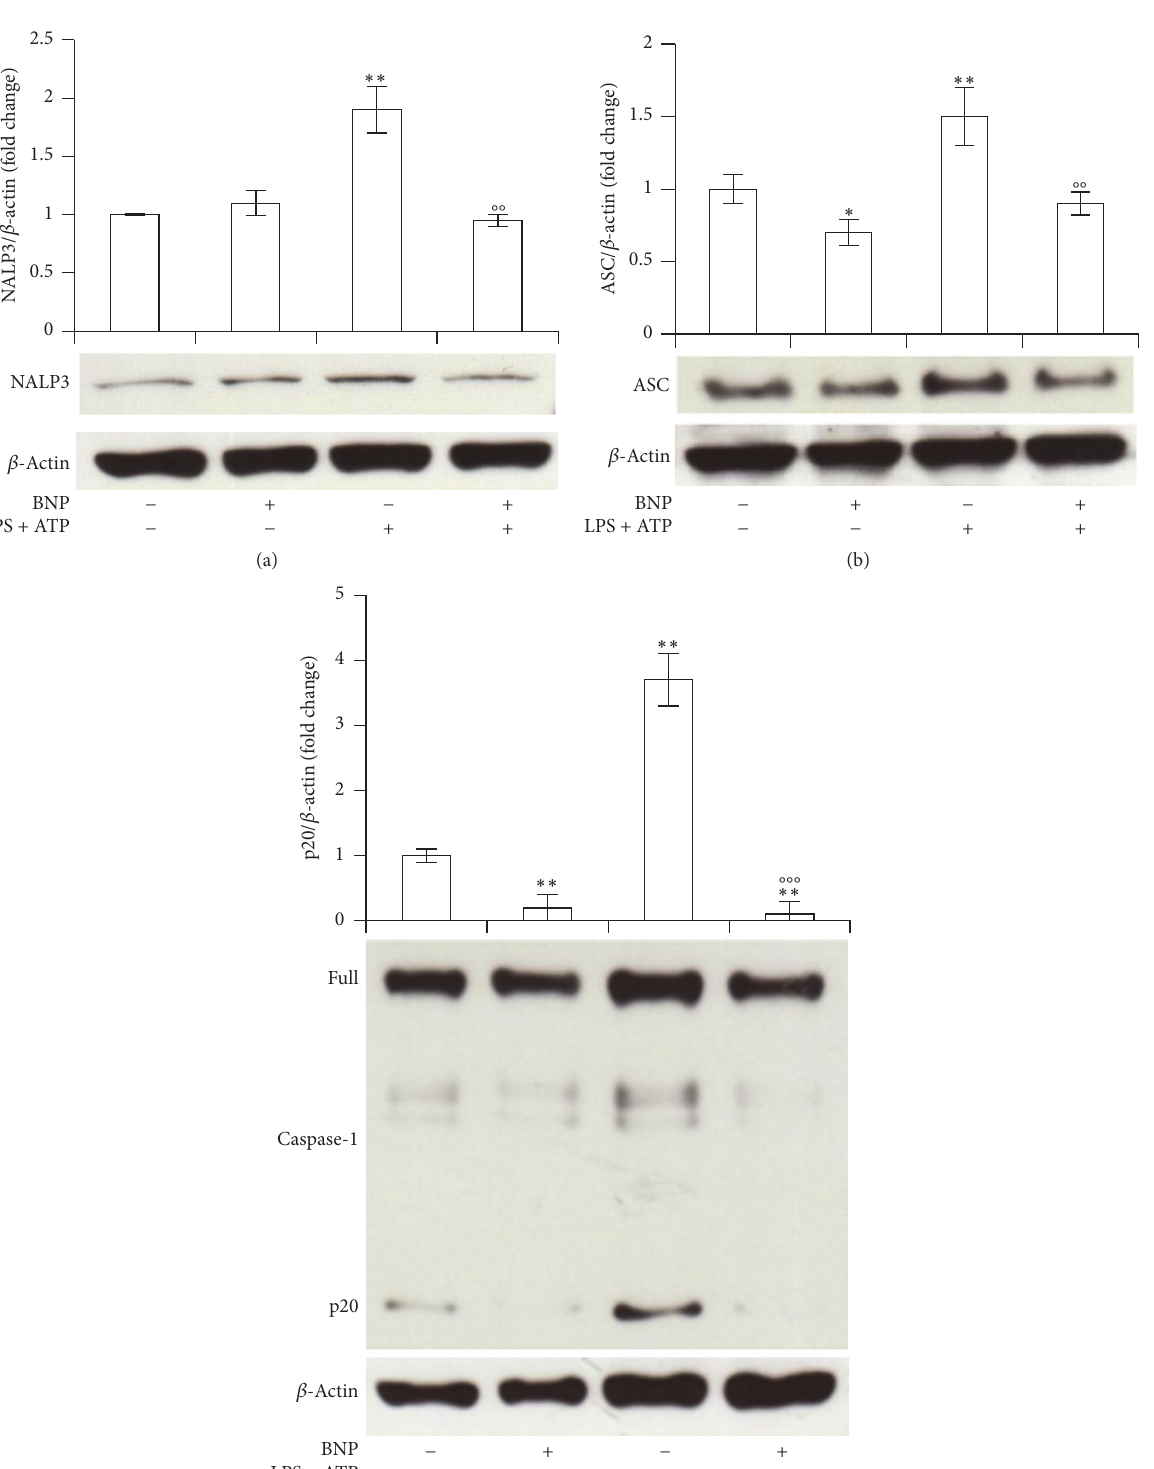
Figure 4: BNP is involved in the second mechanism controlling IL-1 𝛽 production by inhibiting NALP3, ASC, and Caspase-1 cascade activation in THP-1 cells. THP-1 cells were treated with 10 −8 M BNP in absence or presence of 10 𝜇 g/mL LPS/5 mM ATP for 30 min. Cell lysates were immunoblotted for NALP3 (a), ASC (b), or Caspase-1 (c). The blots were stripped of the bound Ab and reprobed with mouse anti- 𝛽 -actin, to confirm equal loading. Western blots are representative of three separate experiments. Histograms indicate means ± SD of three separate experiments each one tested in triplicate. ∗ 𝑃 < 0.05 and ∗∗ 𝑃 < 0.01 versus untreated cells and ∘∘ 𝑃 < 0.01 and ∘∘∘ 𝑃 < 0.001 versus LPS/ATP treated